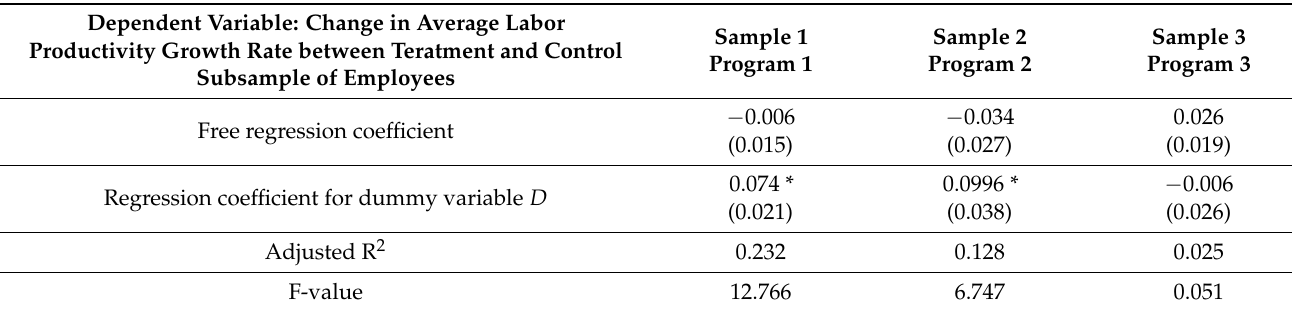
Table 5. Estimated parameters for model